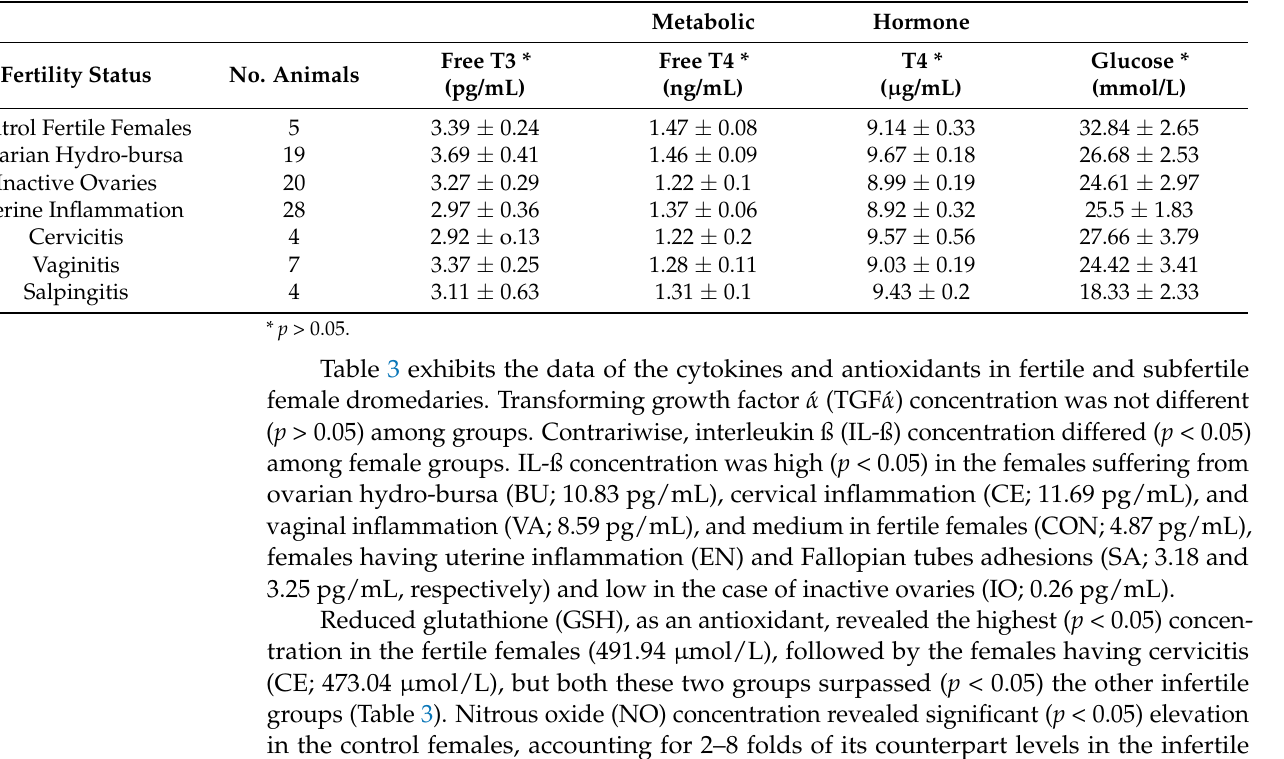
Table 2. Effect of the fertility status of the female dromedary camel on metabolic hormones and glucose (Mean ± SEM). Metabolic Hormone